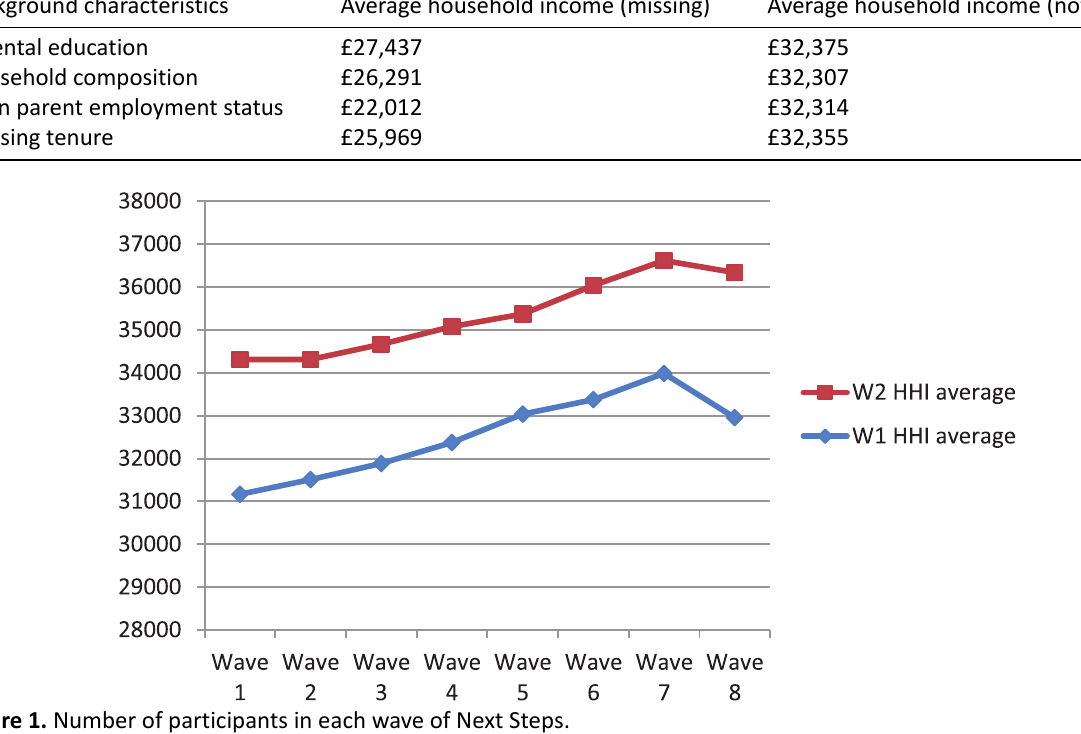
Figure 1. Number of participants in each wave of Next Steps. tial participants had dropped out, and the situation con- tinued to deteriorate with each wave.